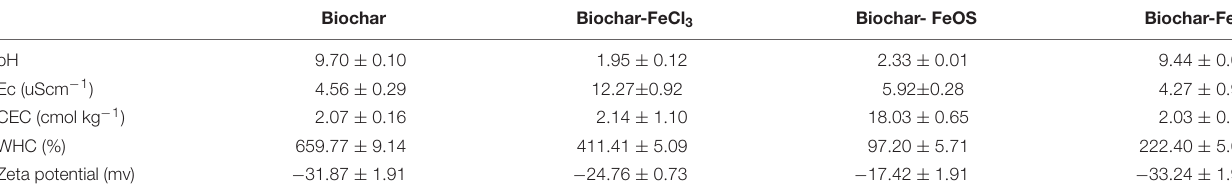
FIGURE 2 | The content of elements (A) and the molar ratio (B) of biochar or iron modified biochar. TABLE 2 | The properties of biochar with and without iron modification. Biochar Biochar-FeCl 3 Biochar- FeOS